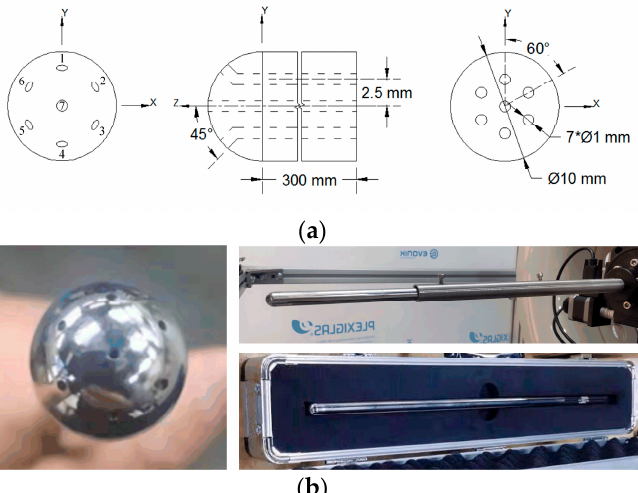
Figure 2. Picture of hemispherical seven-hole probe. ( a ) Schematic diagram of the probe structure, and ( b ) Photograph of the probe.